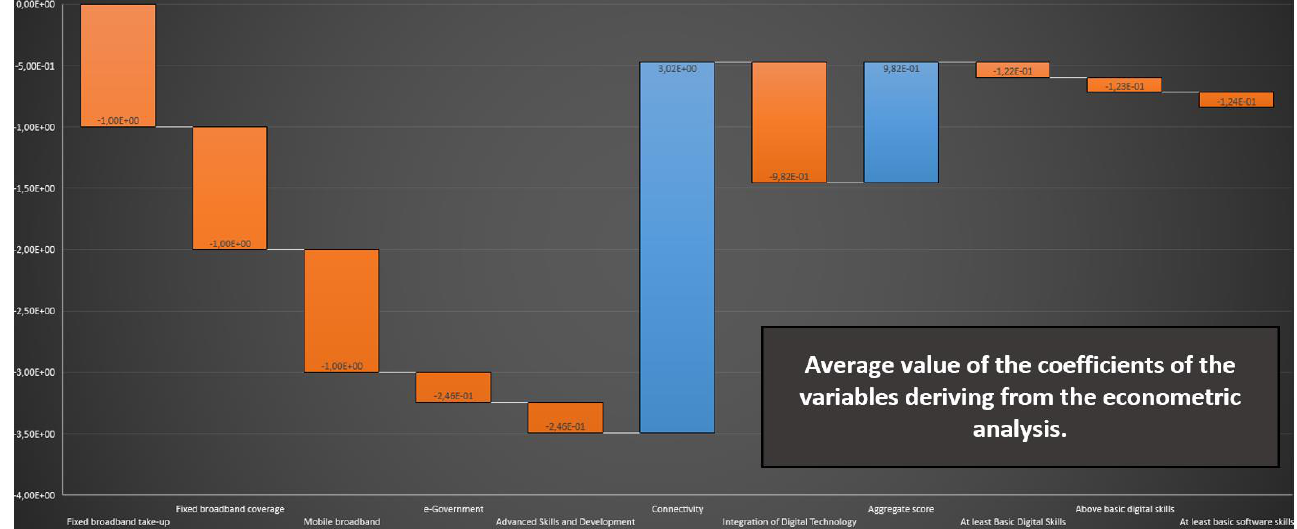
Figure 2. Average value of the coefficients of the variables deriving from the econometric